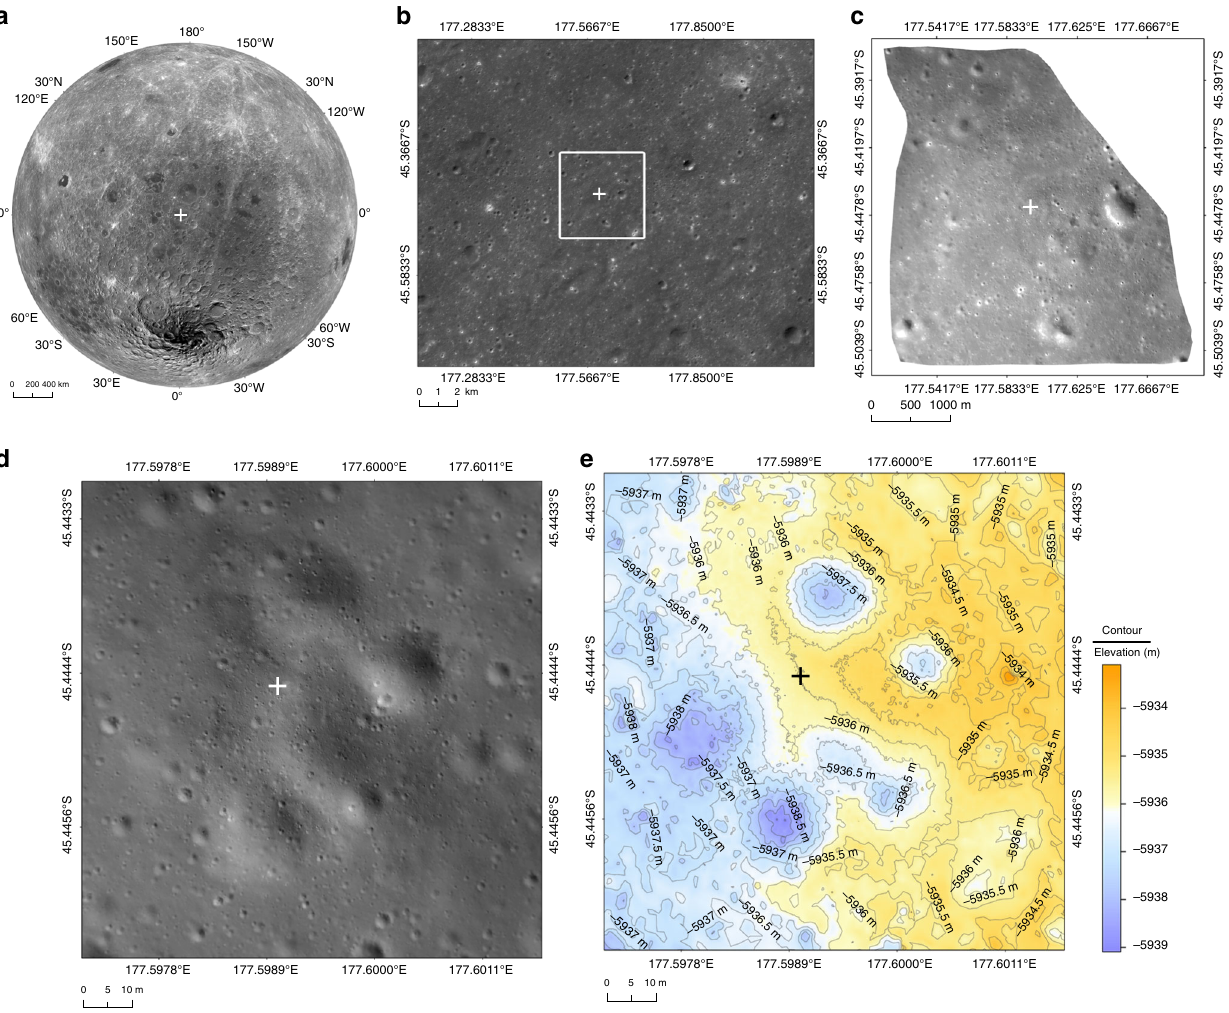
Fig. 3 Location of the CE-4 landing site. The + is the identi fi ed landing location. a , b are the CE-2 DOMs, using the CE-4 landing site as the projection center of the azimuth projection. c is the LCAM DOM with a resolution of 5 m/p. d is the LCAM DOM, which is generated by the LCAM images with resolutions from 21.4 cm/p to 0.2 cm/p and is uniformly resampled at 5 cm/p during mapping. e is a shaded-relief map with contour line produced by the LCAM DEM, which area and resolution are the same as in ( d )